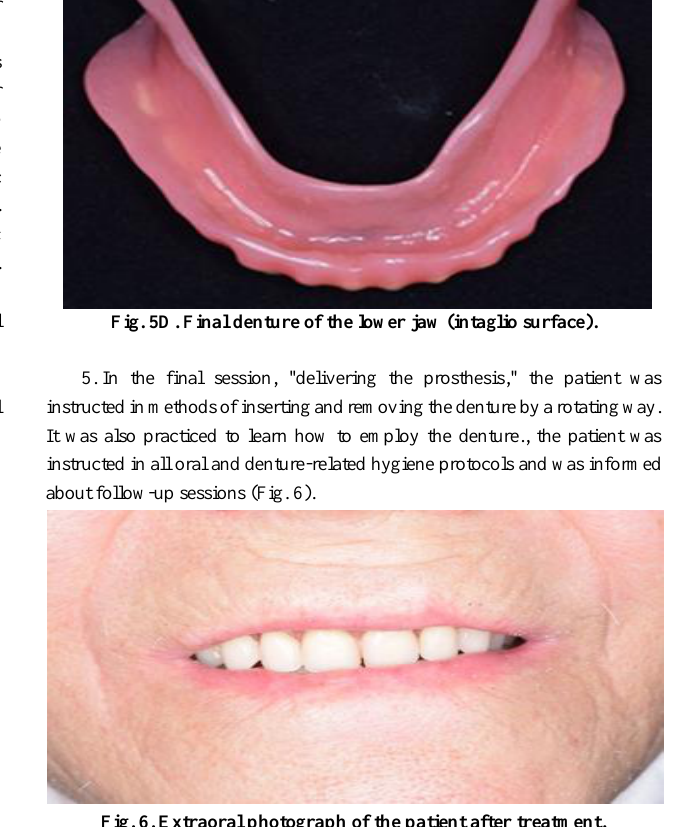
Fig. 6. Extraoral photograph of the patient after